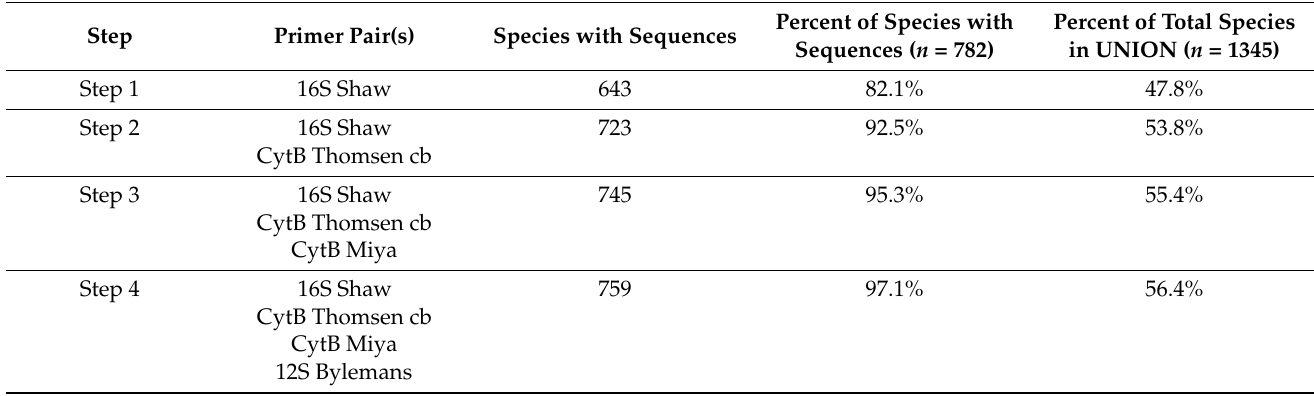
Table 1. Stepwise selection of primer pairs for UNION fish species list with 782 species with